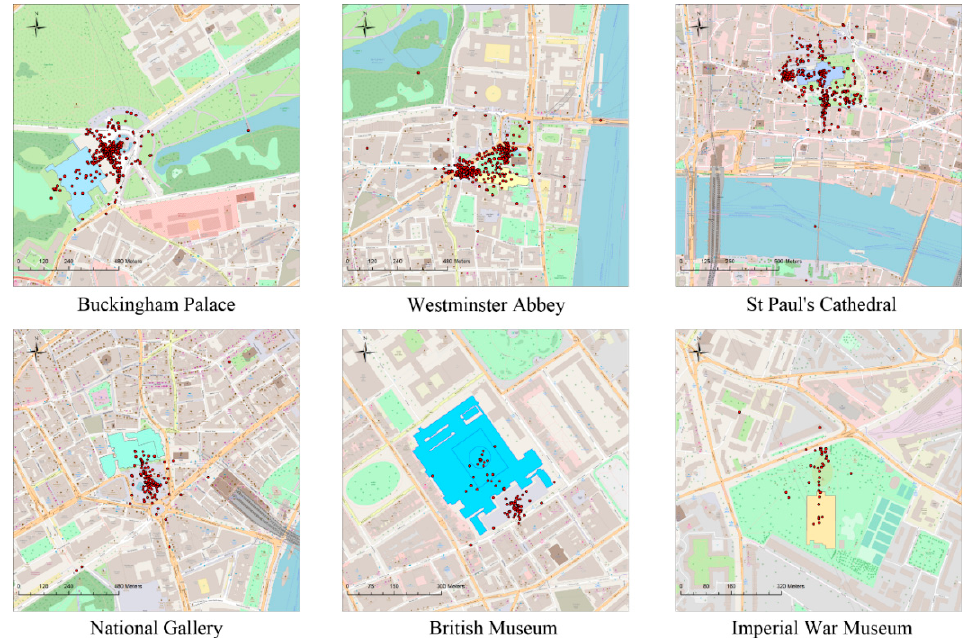
Figure 10. Spatial distribution of relevant images (red dots) of each landmark.